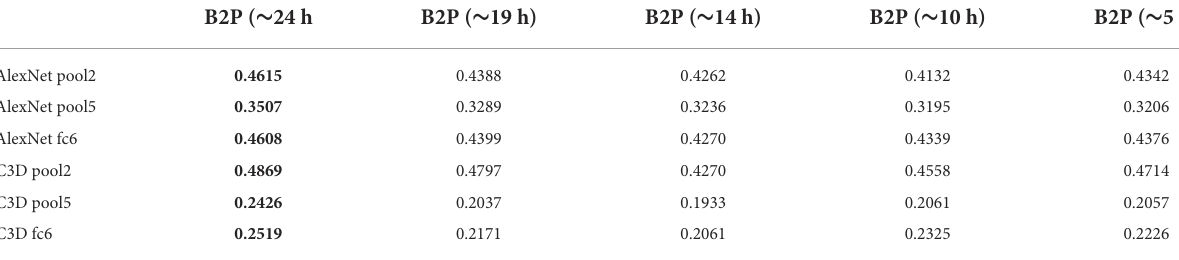
TABLE 7 Splitted data correlation values: the model was trained on data worth of 5, 10, 14, 19, and 24